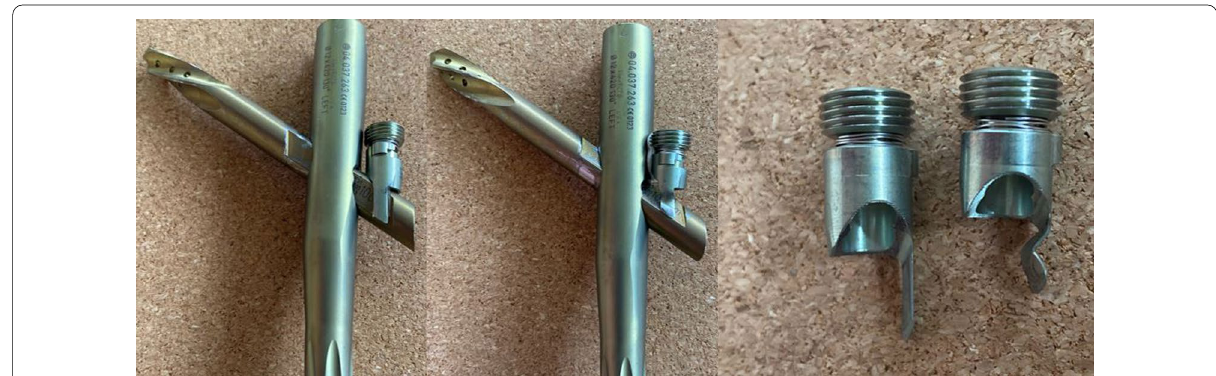
Fig. 8 Far left, the helical blade has been inserted correctly so that the orientation of the recess on the side of the helical blade docks with the locking prong correctly and allows the set screw to be seated fully. Pictured middle, with an under-inserted helical blade, this recess is no longer aligned with the trajectory of the set screw. In this scenario, the set screw will advance until the lock prong contacts the superior aspect of the blade/screw resulting in deformation. Pictured right, a comparison of an intact locking prong and a deformed locking